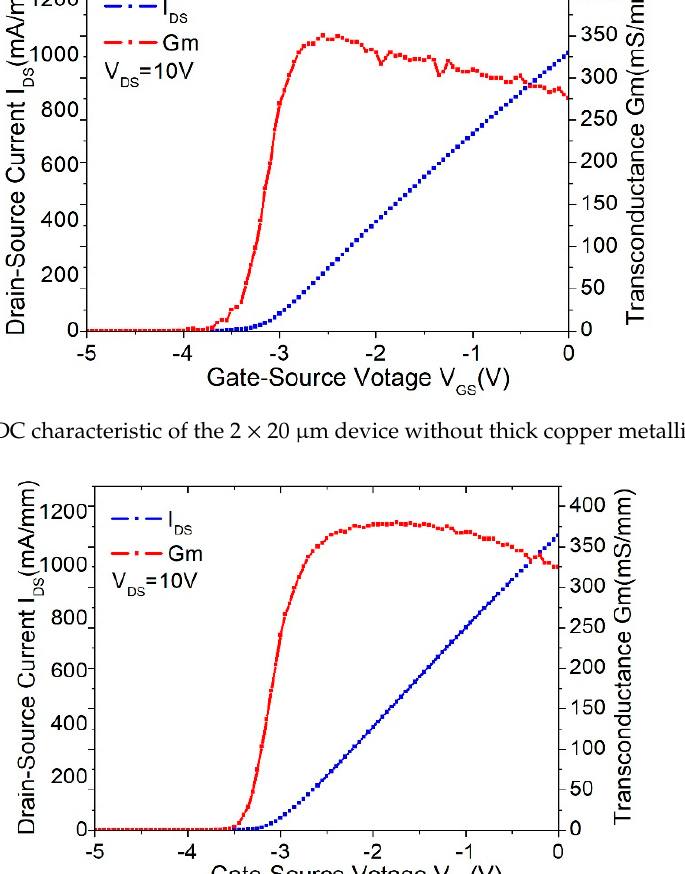
Figure 6. DC characteristic of the 2 × 20 μ m device with thick copper metallization.